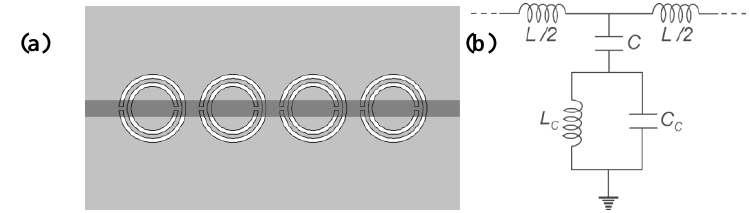
Figure 11. ( a ) Typical topology of a CSRR loaded microstrip line. ( b ) Equivalent circuit model of the unit cell.